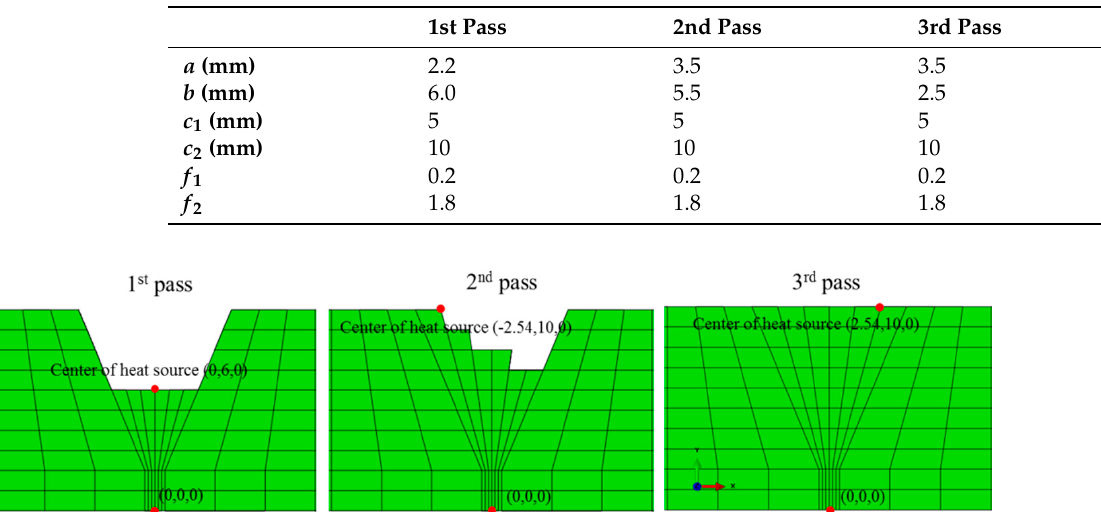
Table 2. Heat source parameters.